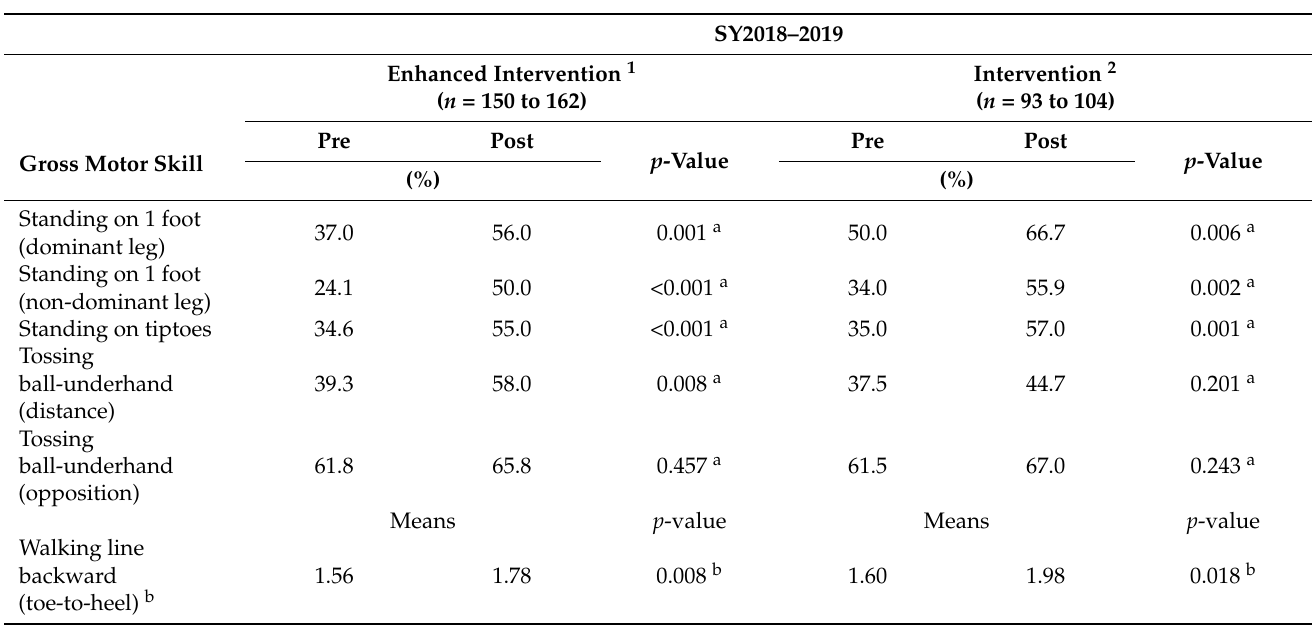
Table 4. Percent of preschool child participants that met gross motor (GM) skill proficiency and mean scale score for walking line backgrounds at pre- and post-intervention during school year